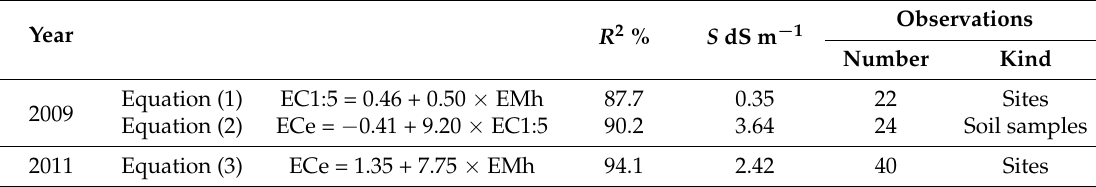
Table 2. Regression equations with their coefficient of determination ( R 2 ), standard error ( S ), and the number and kind of observations used in the regressions Total number of sites of EMI readings, sites by ha, and % inverted profiles (EMv < EMh); number of soil sampling sites, depth, sampling depth interval, and number of samples.